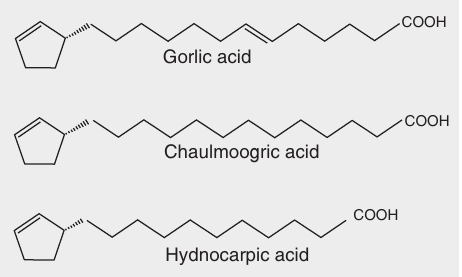
Figure 1. Chemical structures of the major cyclopentenyl fatty acids from seeds of Carpotroche brasiliensis